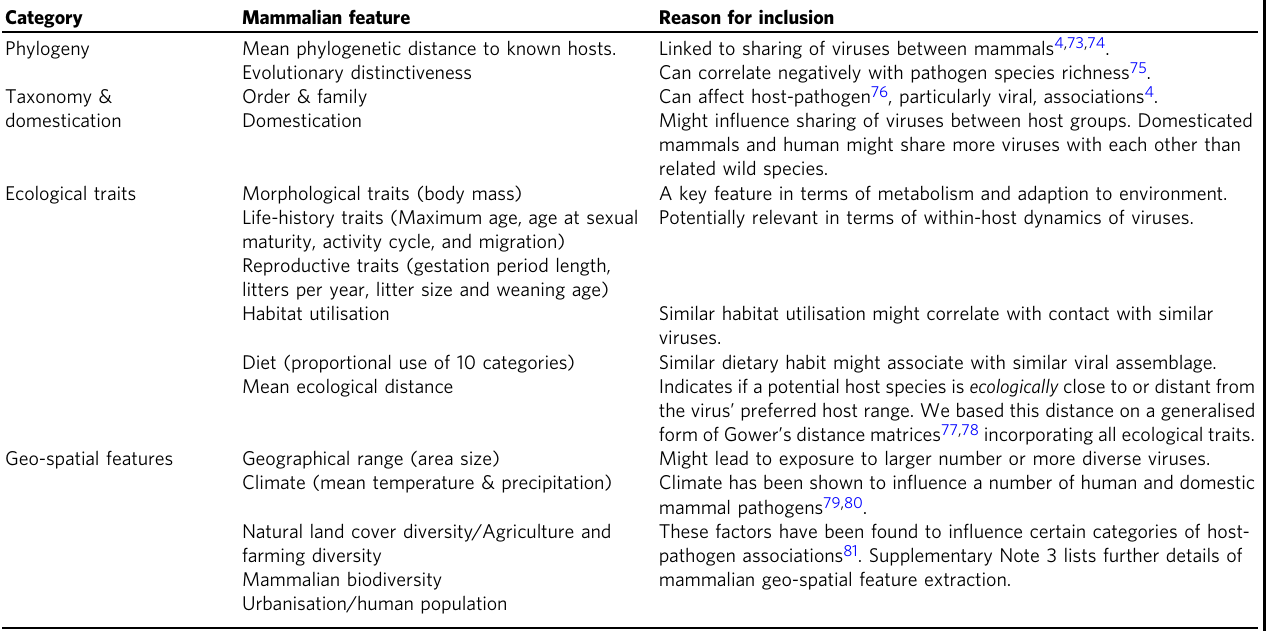
Table 2 mammalian traits & features used to build our viral